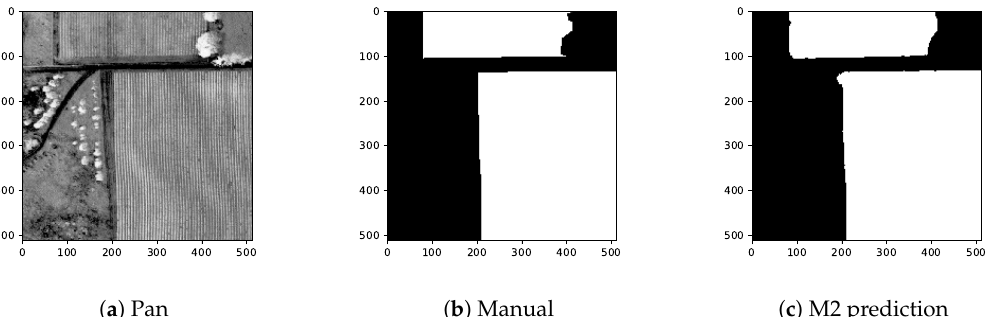
Figure 5. An example patch of size 512 × 512 pixels for M2 with good results, JI = 98.7%, Precision = 99.1%, Recall = 99.6%.